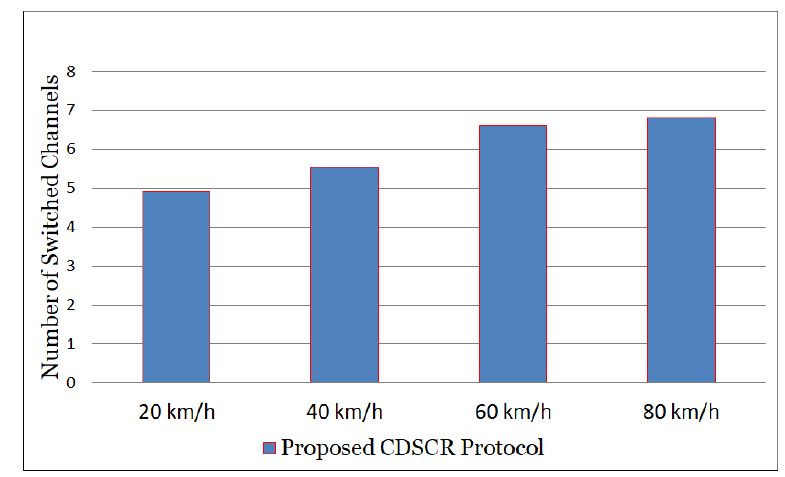
Figure 10. Number of switched channels versus node